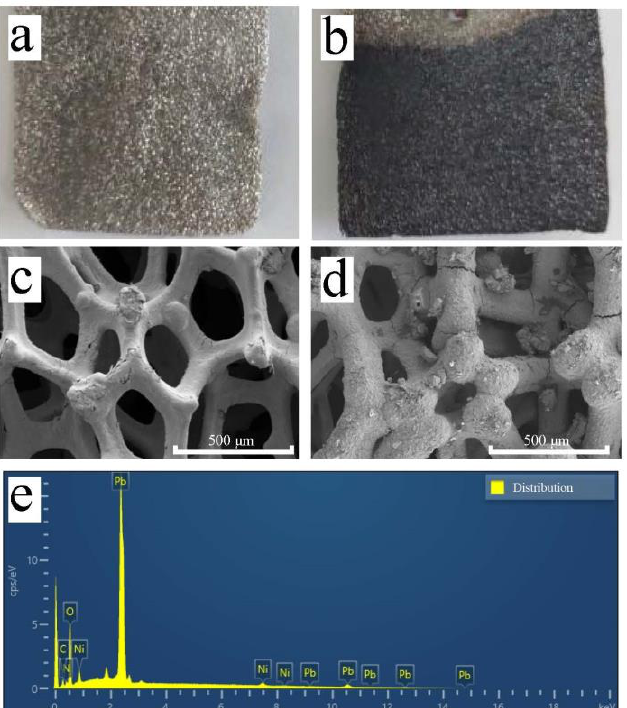
Figure 2. Physical drawing of the nickel foam ( a ) and PbO 2 -FN ( b ). SEM of nickel foam ( c ) and PbO 2 -FN ( d ). EDS spectrogram of PbO 2 -FN ( e ).